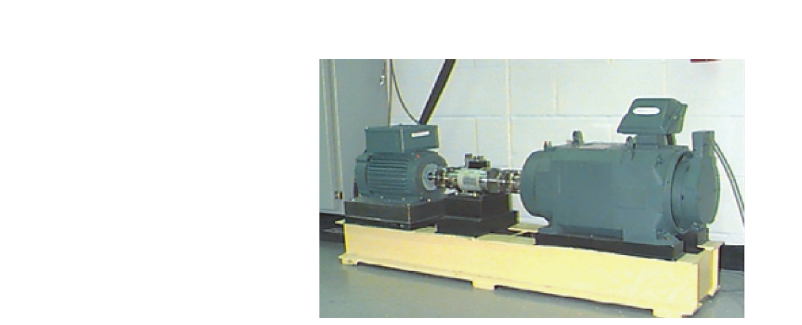
Figure 3: CWRU bearing test rig. Table 1: The label of bearing